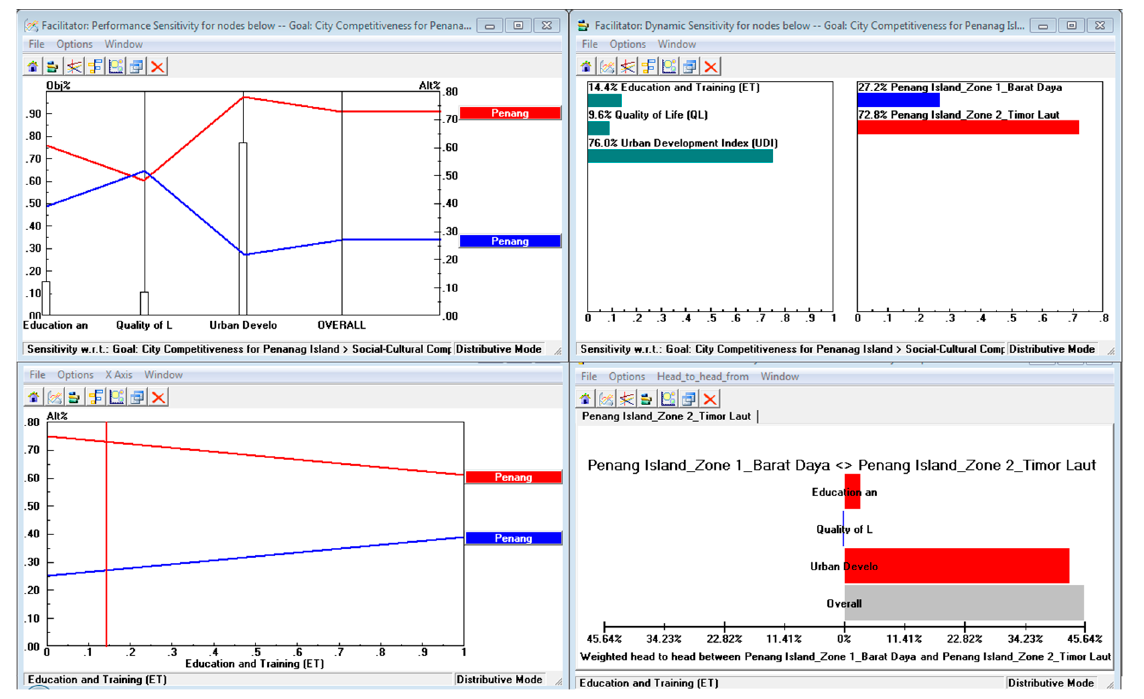
Figure 7. Dynamic, gradient, head-to-head, 2D-sensitive analysis chart of social–cultural criteria and alternatives in the Expert Choice score.